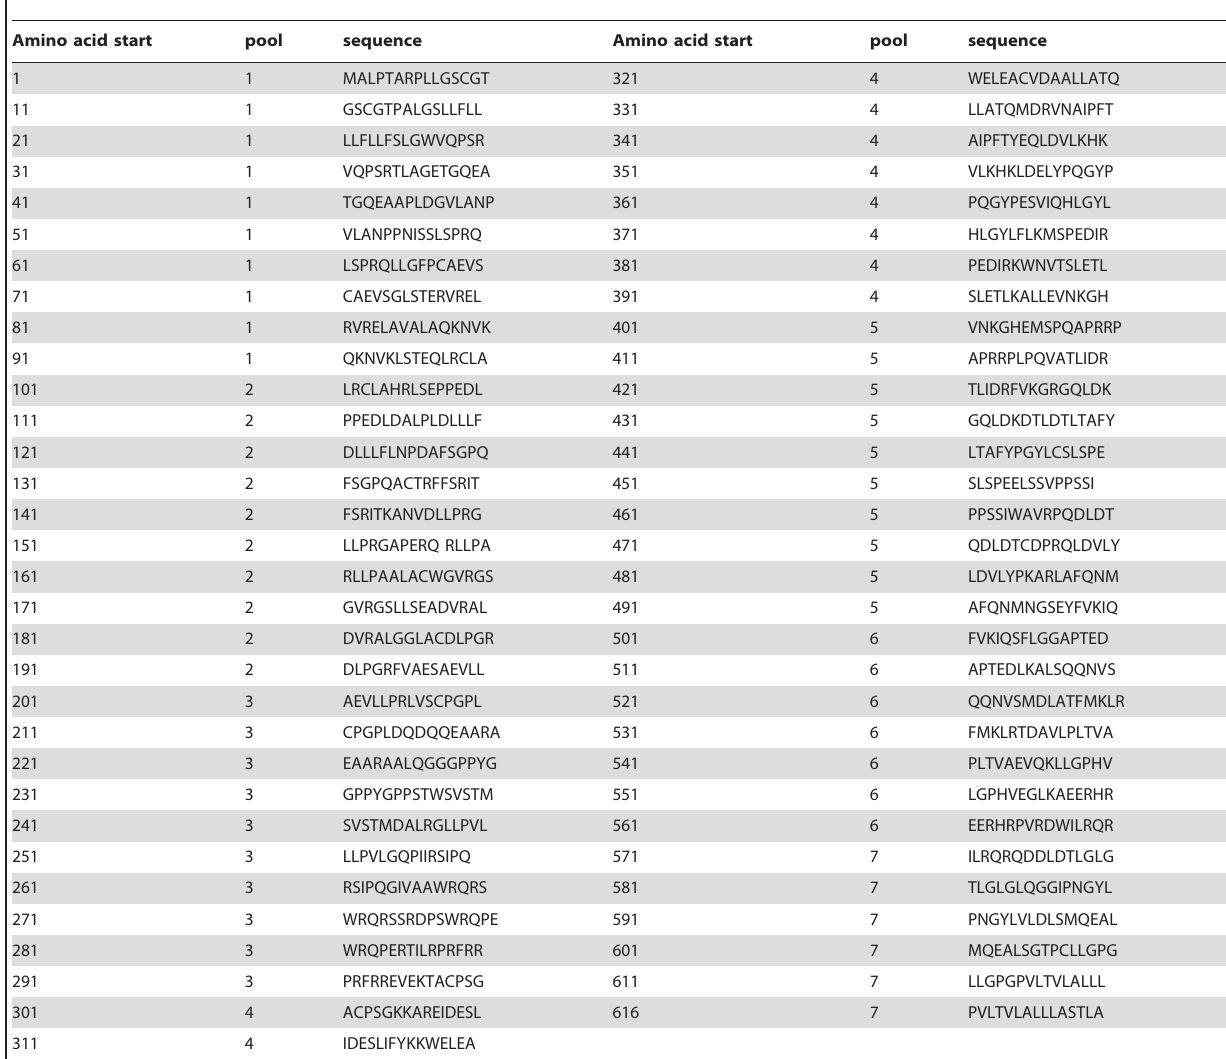
Table 3. Mesothelin-derived